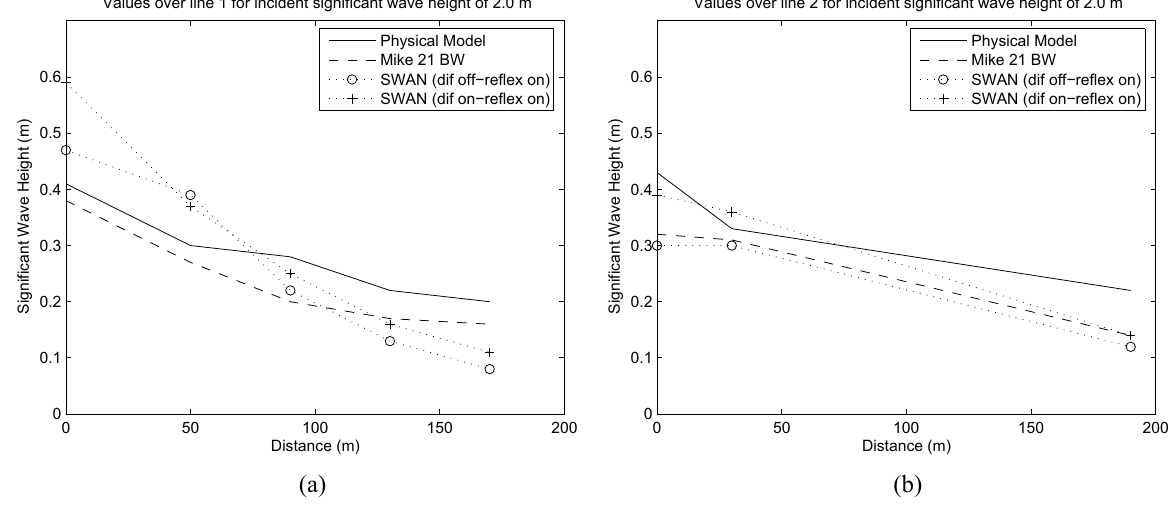
Fig. 5 – Significant wave height measured in the physical model and estimated by the models MIKE 21 BW and SWAN with reflection on for: diffraction off (dif off—reflex on) and diffraction on (dif on—reflex on). For incident significant wave height of 2.0 m (over Line 1 (a) and over Line 2 (b)).